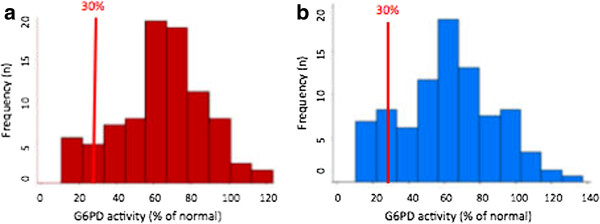
G6PD distribution by gender. a) Among 110 females, 84.5% had G6PD levels ranging from 60% to 123% activity; 9.37% of females had G6PD activity lower than 30% - the activity threshold established by the WHO as posing a risk for primaquine administration at the present regime. Most females had activity values between 60 and 80%. b) Among 125 males, 76.8% had G6PD levels ranging from 40.3% to 137.8%. 9.4% of males had values lower than 30% activity. Most males had activity values in the 60-70% range.